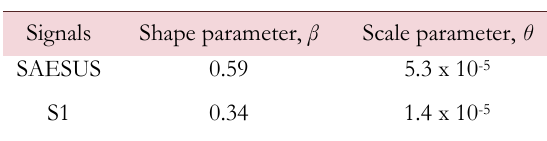
Table 1: Statistical data analysis based on Weibull distribution.